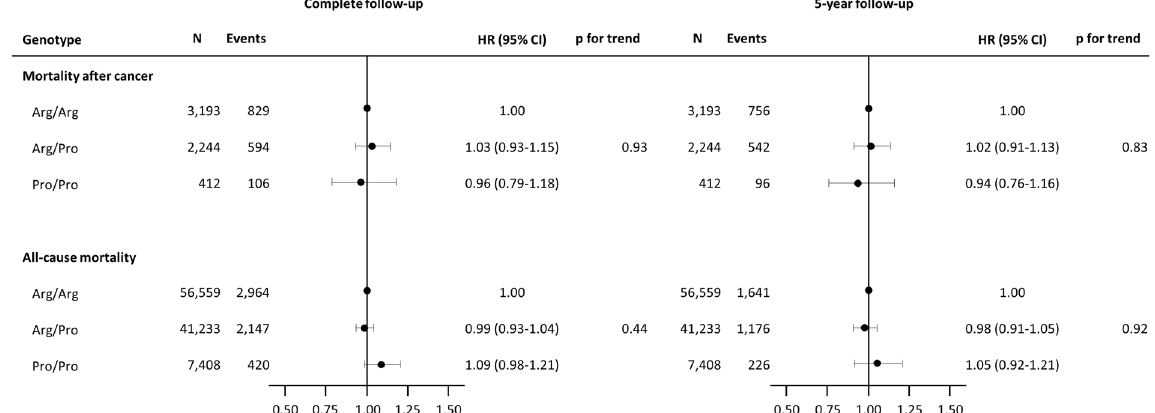
Figure 1. Hazard ratios for mortality after cancer and for all-cause mortality according to TP53 Arg72Pro genotype in the general population. Hazard ratios were adjusted for sex and age in all analyses. Follow-up started at first cancer diagnosis after baseline (mortality after cancer) or the day of baseline examination (all- cause mortality), and ended on the day of death, emigration or November 14, 2014, whichever came first. In the mortality after cancer analysis with 5 year follow-up, follow-up ended 5 year after cancer diagnosis, death, emigration, or November 14, 2014 whichever came first. In the all-cause mortality analysis with 5